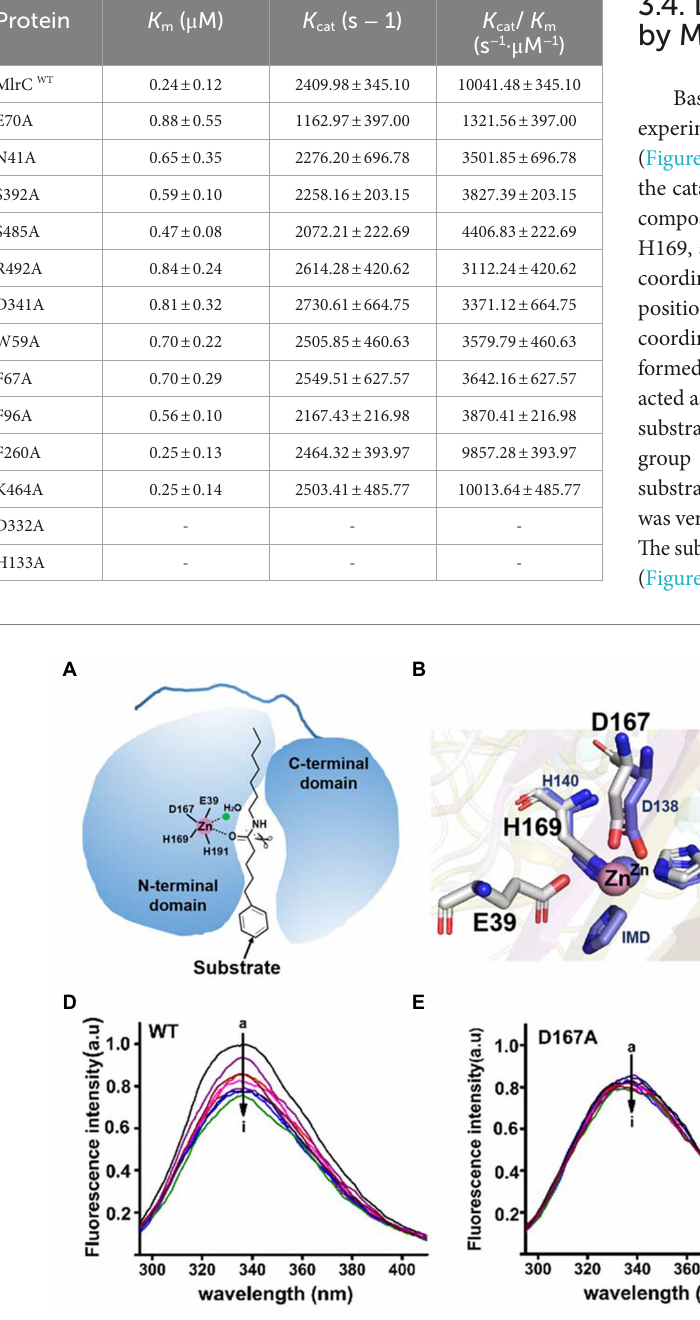
FIGURE 3 Analysis of the relationship between the MlrC enzyme, zinc ion, and linearized MC-LR. (A) Schematic model of the MlrC monomer structure and substrate. The two domains, the zinc ion with coordinated residues and the substrate model, are indicated. (B) Alignment of the zinc ion and coordinated residues between MlrC and 3IUU. (C) Schematic of the E-M-S model of the relationship between the MlrC enzyme, zinc ion, and linearized MC-LR, with the zinc ion acting as a metal bridge connecting the MlrC enzyme and substrate. (D–F) Synchronous fluorescence spectra of MlrC and variants: (D) wild-type MlrC; (E) D167A; and (F) H169A. The concentration of MlrC: 1 μ M, and the concentration of linearized MC-LR a–i: 0, 1, 2, 3, 4, 5, 6, 7, and 8 μ M,